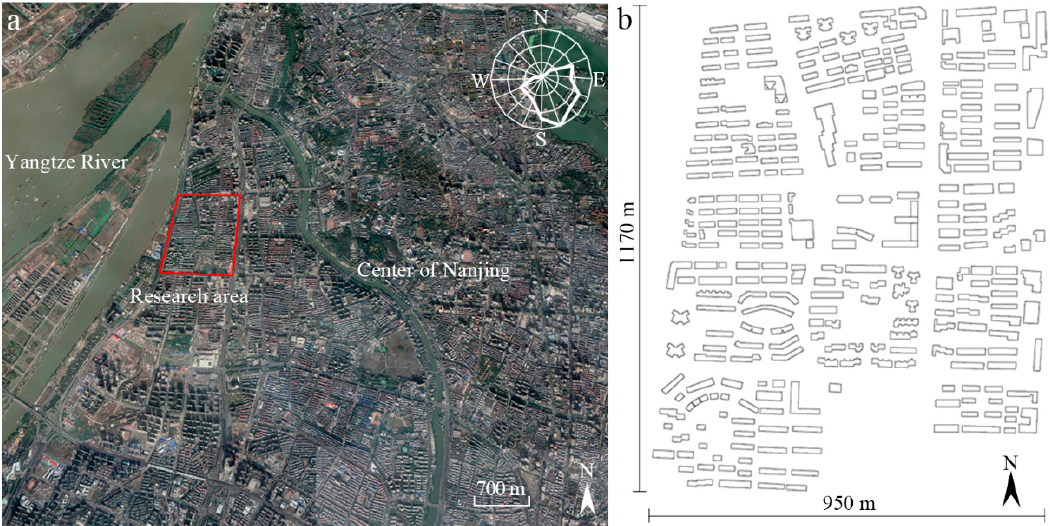
Figure 2. ( a ) Research area location from Google maps. ( b ) Research area plan.